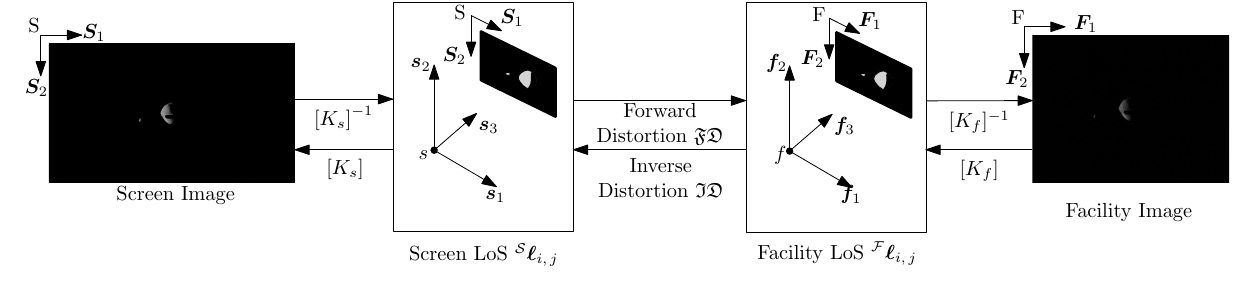
Figure 10. Distortion